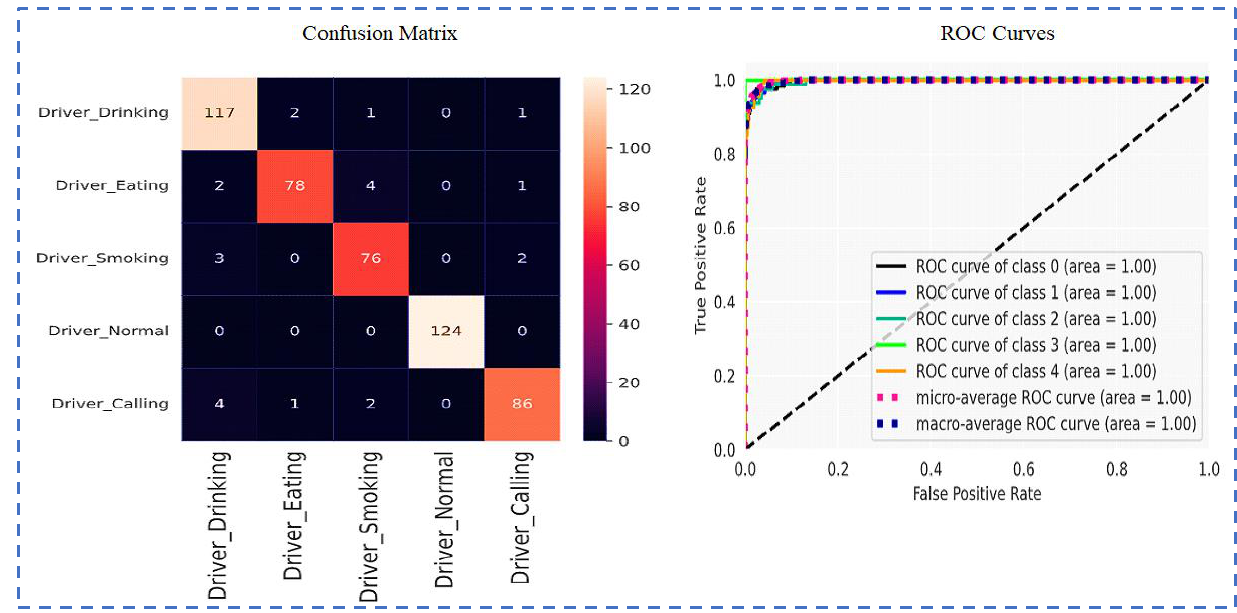
Figure 14. Model loss and model accuracy using the proposed CNN-based model.